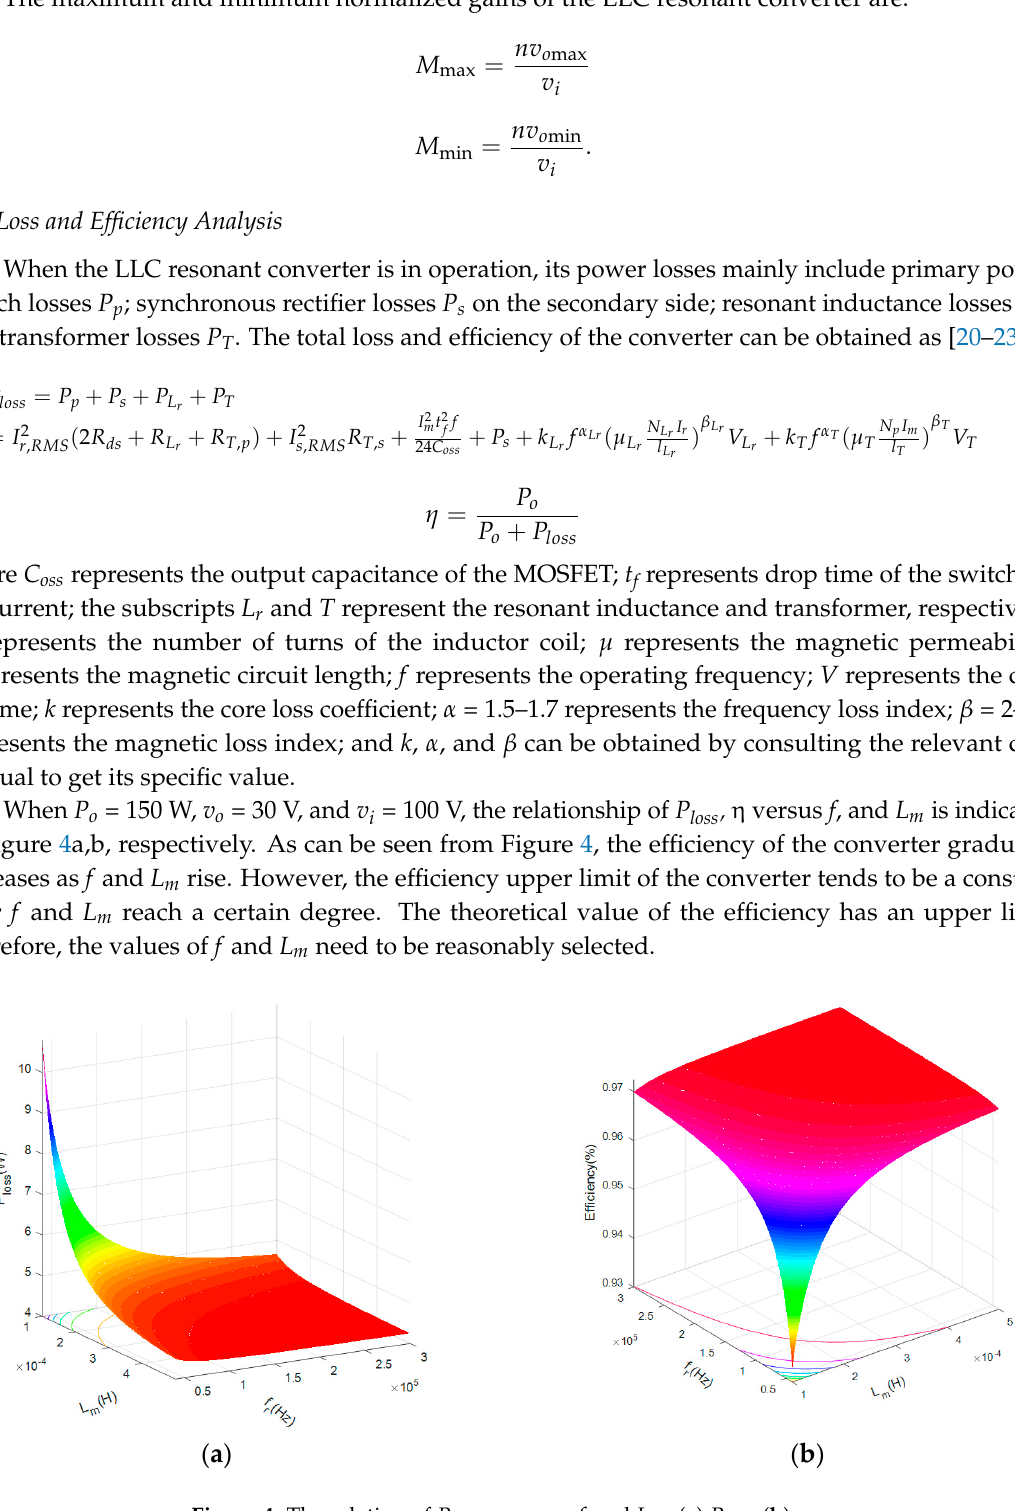
Figure 4. The relation of P loss , η versus f and L m : ( a ) P loss ; ( b ) η .